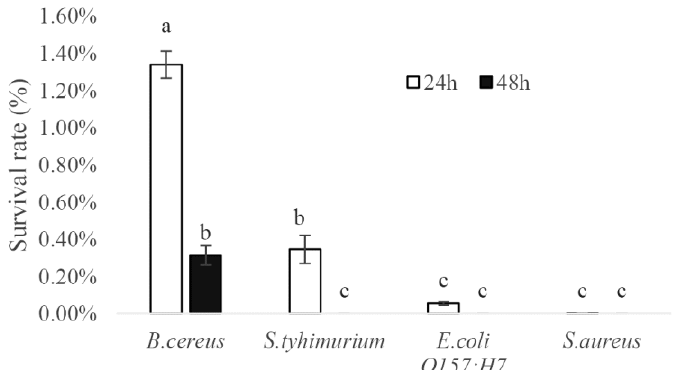
Figure 1. The survival rate of the four pathogenic bacteria ( B. cereus , S. typhimurium , E. coli O157:H7, S. aureus ) after being cocultured with Loigolactobacillus coryniformis NA-3 for 24 h and 48 h. a, b, c — Different lowercase letters mean significant differences ( p < 0.05).